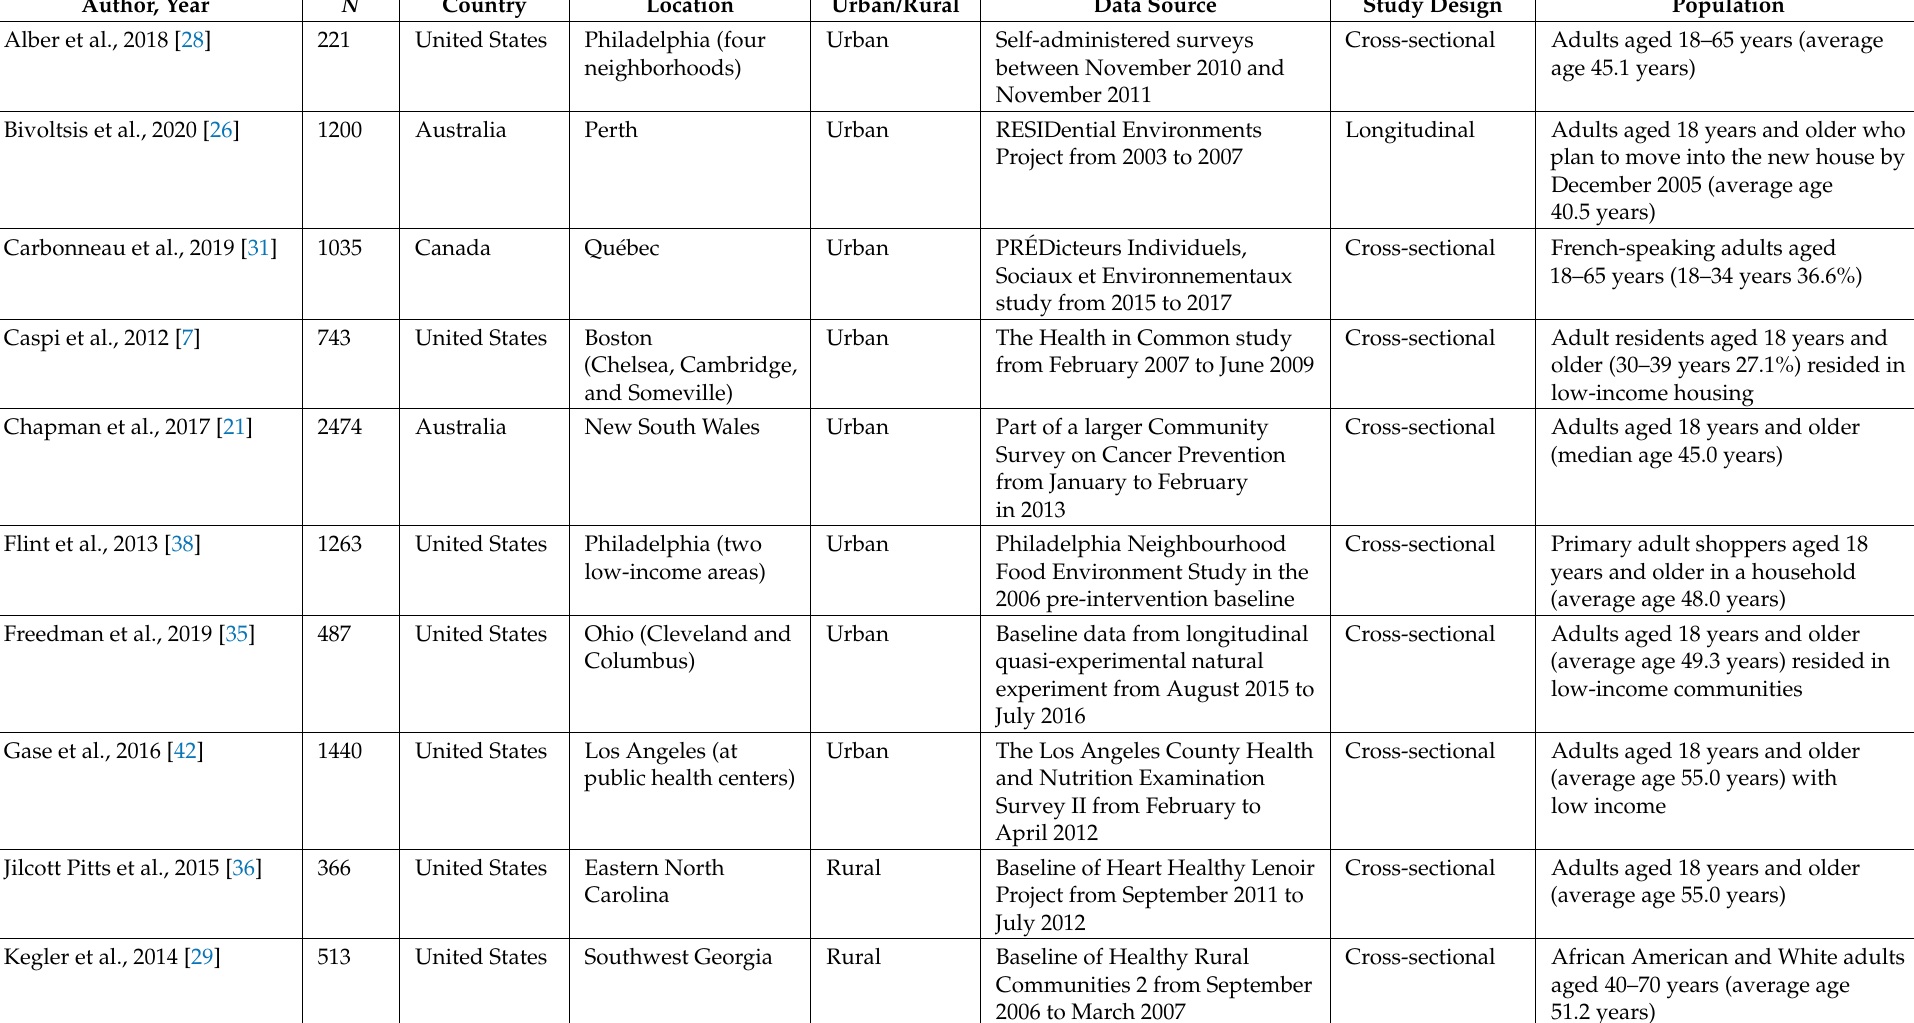
Table 1. Study designs of the reviewed